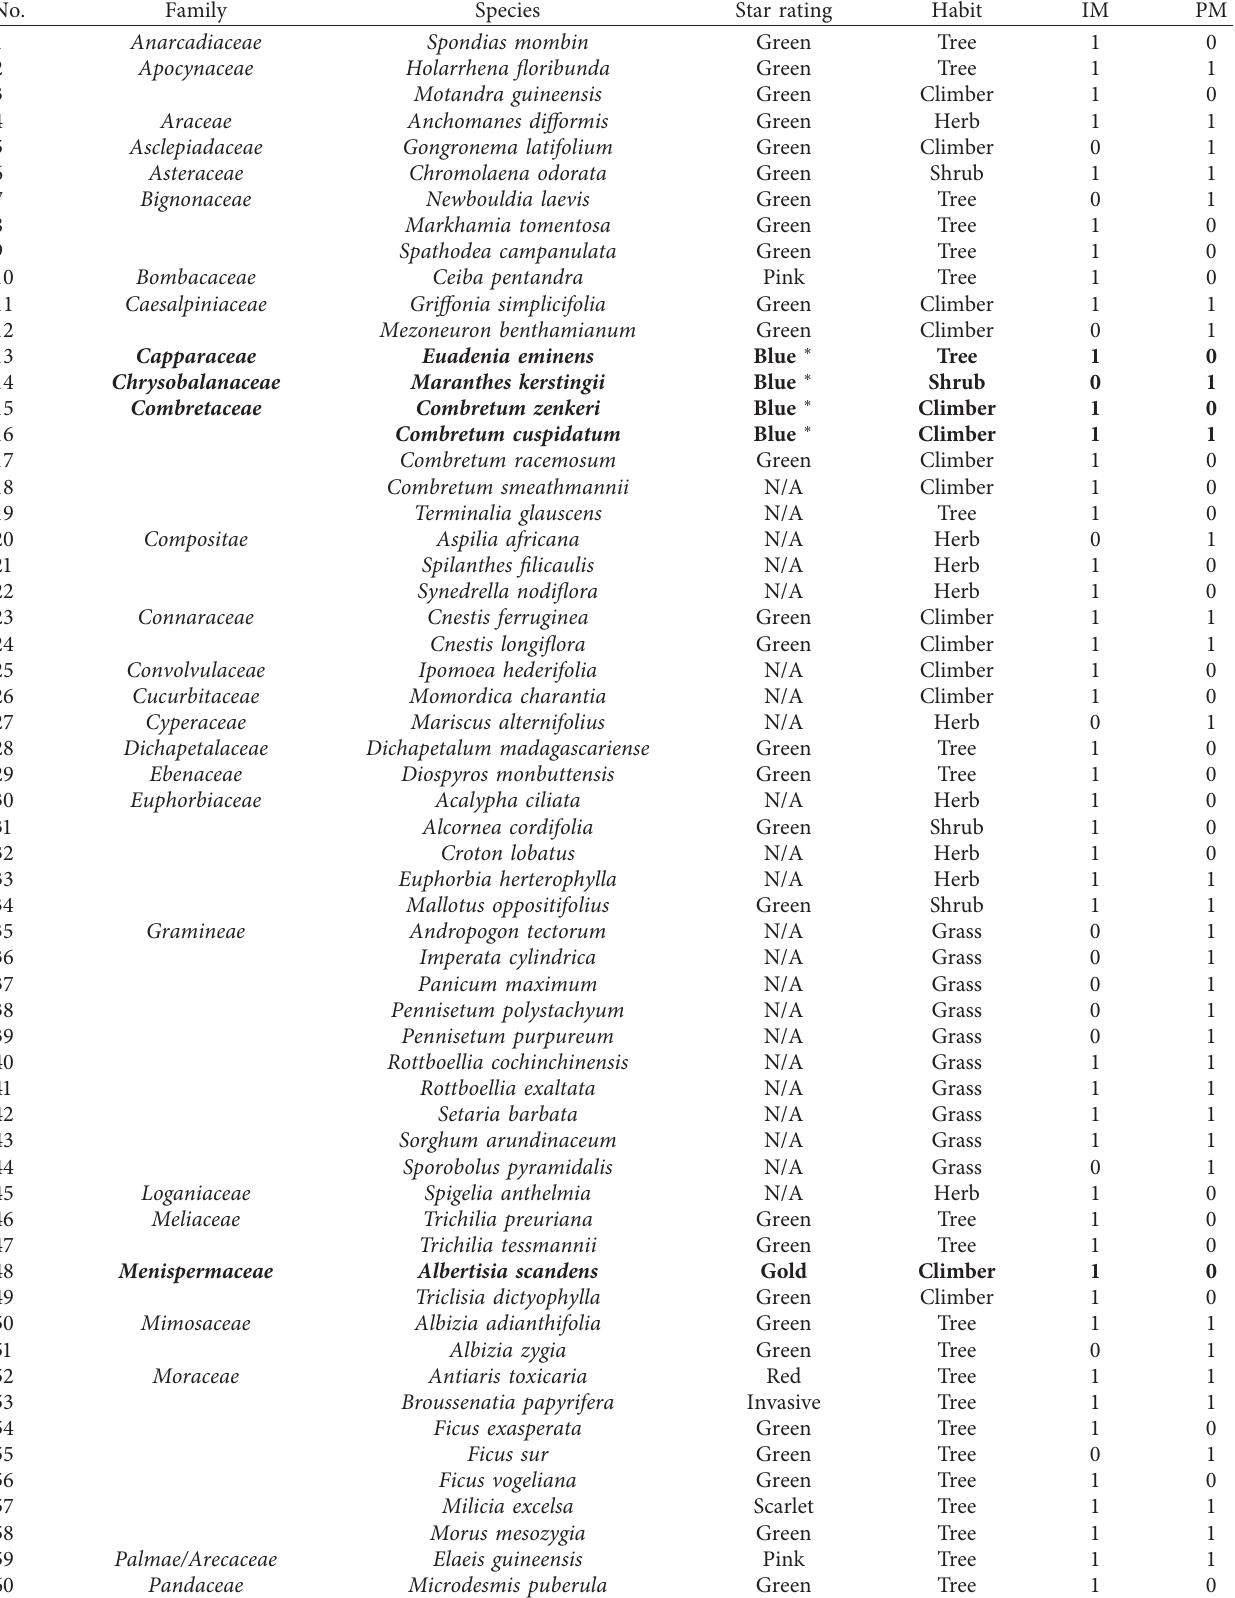
Table 2: Understorey species found in the intensively and poorly managed Tectona grandis